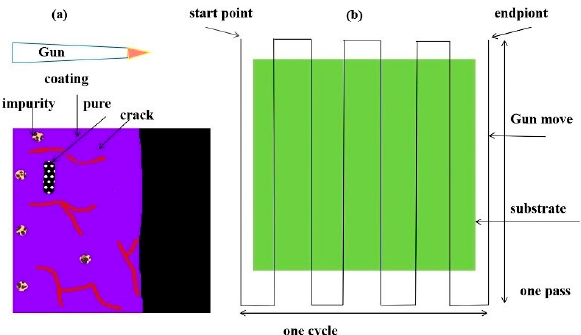
Figure 2. ( a ) The microstructure of the as-sprayed coating ( b ) Raster pattern in the x – y plane for one cycle of gun movement [18].